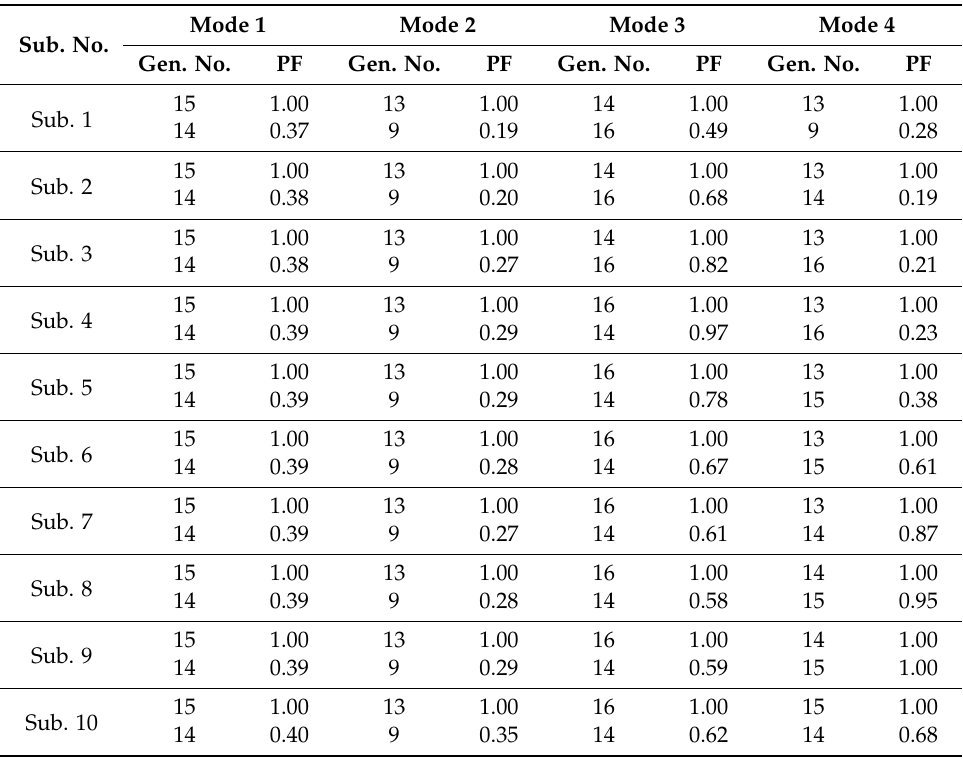
Table 2. Participation factors of different generators in different subspaces. Sub.